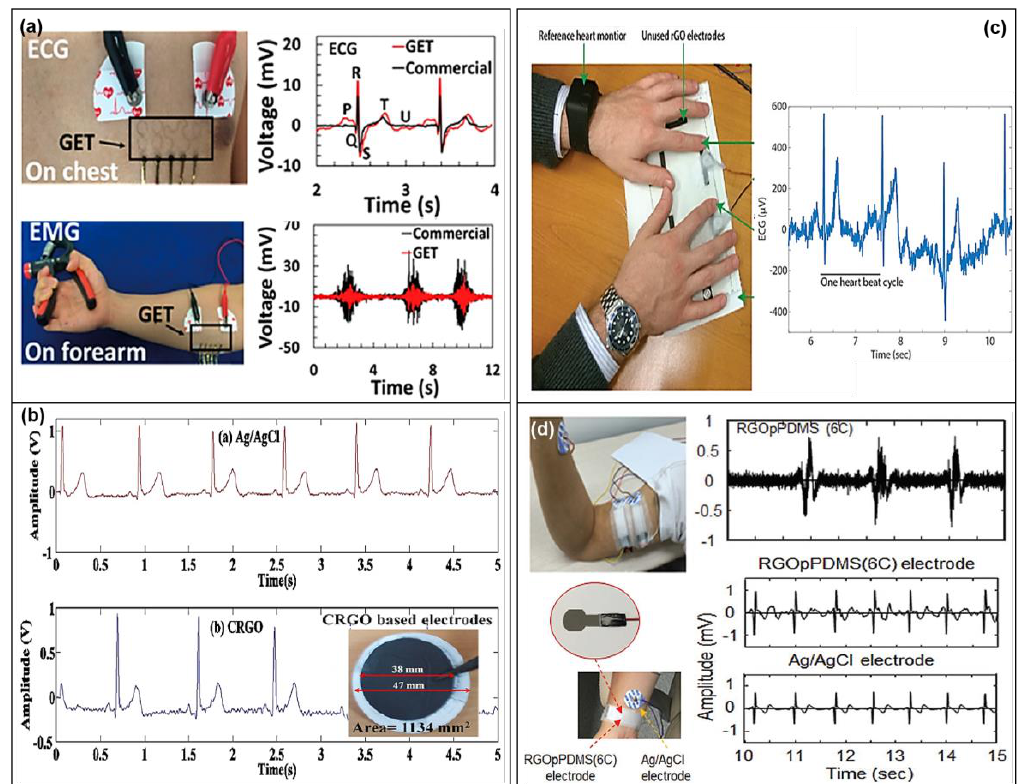
Figure 5. Graphene-based electrophysiological sensors. ( a ) The measurement of ECG and EMG signals by graphene electronic tattoo (GET) sensors attached on chest and forearm, respectively (reproduced with permission [30] copyright 2017, American Chemical Society). ( b ) ECG measurement using a commercial electrode (Ag/AgCl) and chemically reduced graphene oxide-based (CRGO) dry electrodes on paper substrates (reproduced with permission [88] copyright 2017, Elsevier). ( c ) Measuring ECG signal with two fingers placed on printed graphene electrode on fabric substrates (reproduced with permission [89] copyright 2017, Royal Society of Chemistry). ( d ) EMG signals recorded from biceps brachii muscle and ECG signals recorded from right arm using rGOpPDMS bioelectrodes (reproduced with permission [90] copyright 2017, Wiley-VCH).